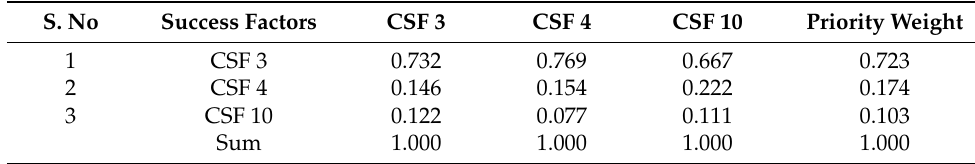
Table 19. Normalized matrix for standard level success factors.